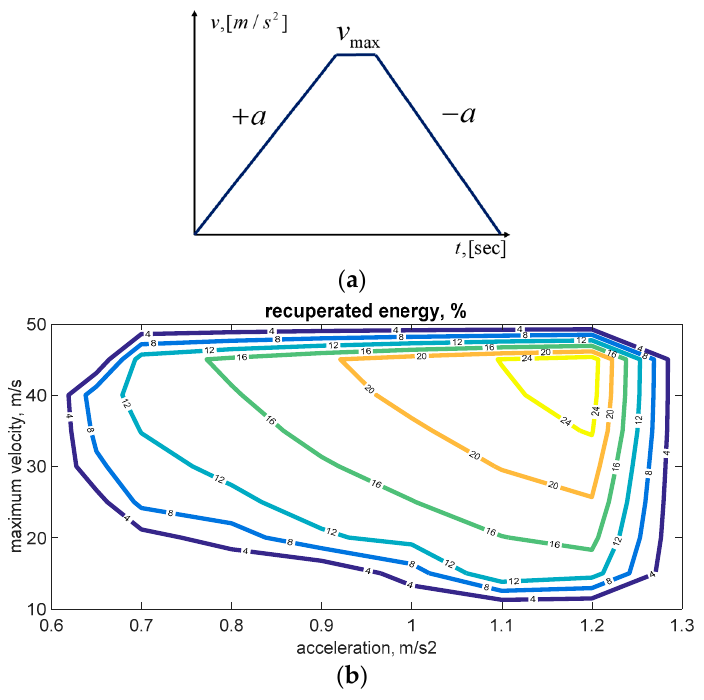
Figure 5. Energy recovery potential over a simple drive cycle: ( a ) speed profile; and ( b ) energy recovery values. Color lines represent isolines with constant recovery potential values.